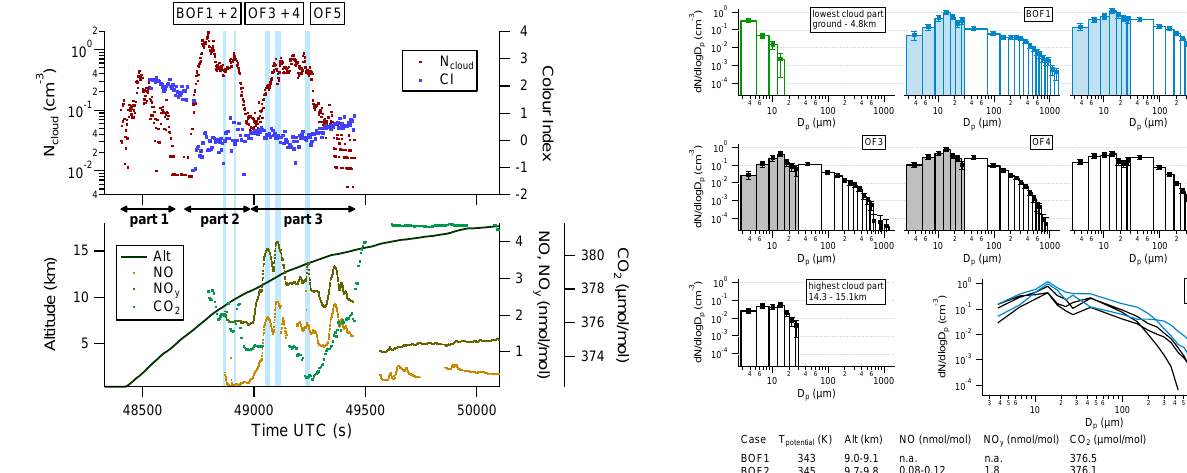
outflow. The difference between the NO and NO y mixing ra- tios is larger than for the young outflow of 7 August which indicates that parts of the NO had already been oxidised.